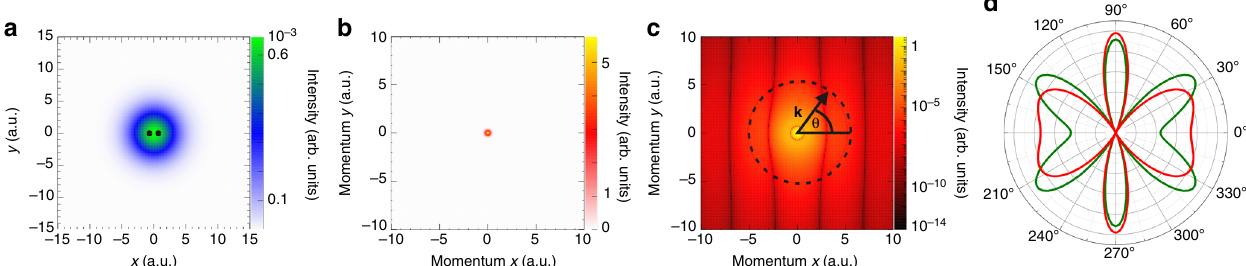
one-electron wave function. a The electronic wave function of H þ in the polarization plane for an internuclear distance R = 1.4 a.u. Fig. 1 Imaging of the H þ 2 2 The positions of the two nuclei are indicated by black dots. b The square of the Fourier transform of a in the ( k x , k y ) plane. c The same as ( b ), but in logarithmic color scale. Notice the appearance of nearly vertical fringes, when k j j is signi fi cantly different from zero. The approximate periodicity of these fringes is Δ k x (cid:2) 2 π = R . The dashed line indicates the region of momentum space associated with an electron kinetic energy of 380 eV (i.e., a radius of k j j ¼ 5 : 3 a.u.) and θ is the angle with respect to the molecular axis. d Polar plot of the intensity distribution in c along the dashed line (red) and the corresponding MFPAD in the plane of polarization of the ionizing radiation obtained from nearly exact calculations